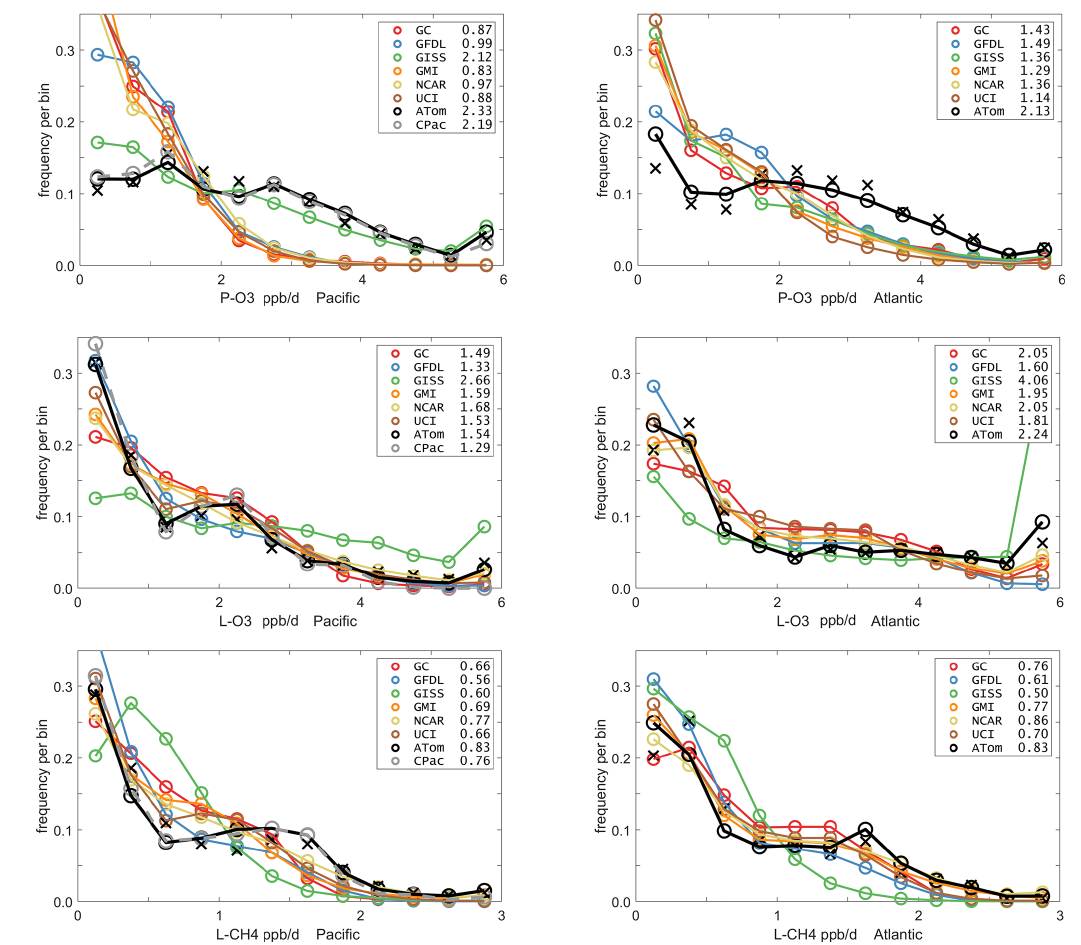
Figure 5. Probability densities (PDs, frequency of occurrence) for the ATom-1 three reactivities (rows: P-O3, L-O3, L-CH4 in ppb/d) and for the Pacific and Atlantic from 54 ◦ S to 60 ◦ N (columns left and right). Each air parcel is weighted as described in the text for equal frequency in large latitude–pressure bins and also by cosine(latitude). The ATom statistics are from the UCI model, using MDS-2 and revised RDS ∗ protocol (HNO 4 and PAN damping). The full Pacific results (solid black) also show just the central Pacific (dashed gray). The six models’ values for a day in mid-August are averaged over longitude for the domains shown in Fig. S1 and then cosine(latitude)-weighted. Mean values (ppb/d) are shown in the legend but are different from some tables where the cosine weighting is not applied. The PD derived from the ATom 10s parcels binned at 1 ◦ latitude and 200m altitude (shown for the tropics only in Fig. 2) is typical of a high-resolution global model and denoted by black